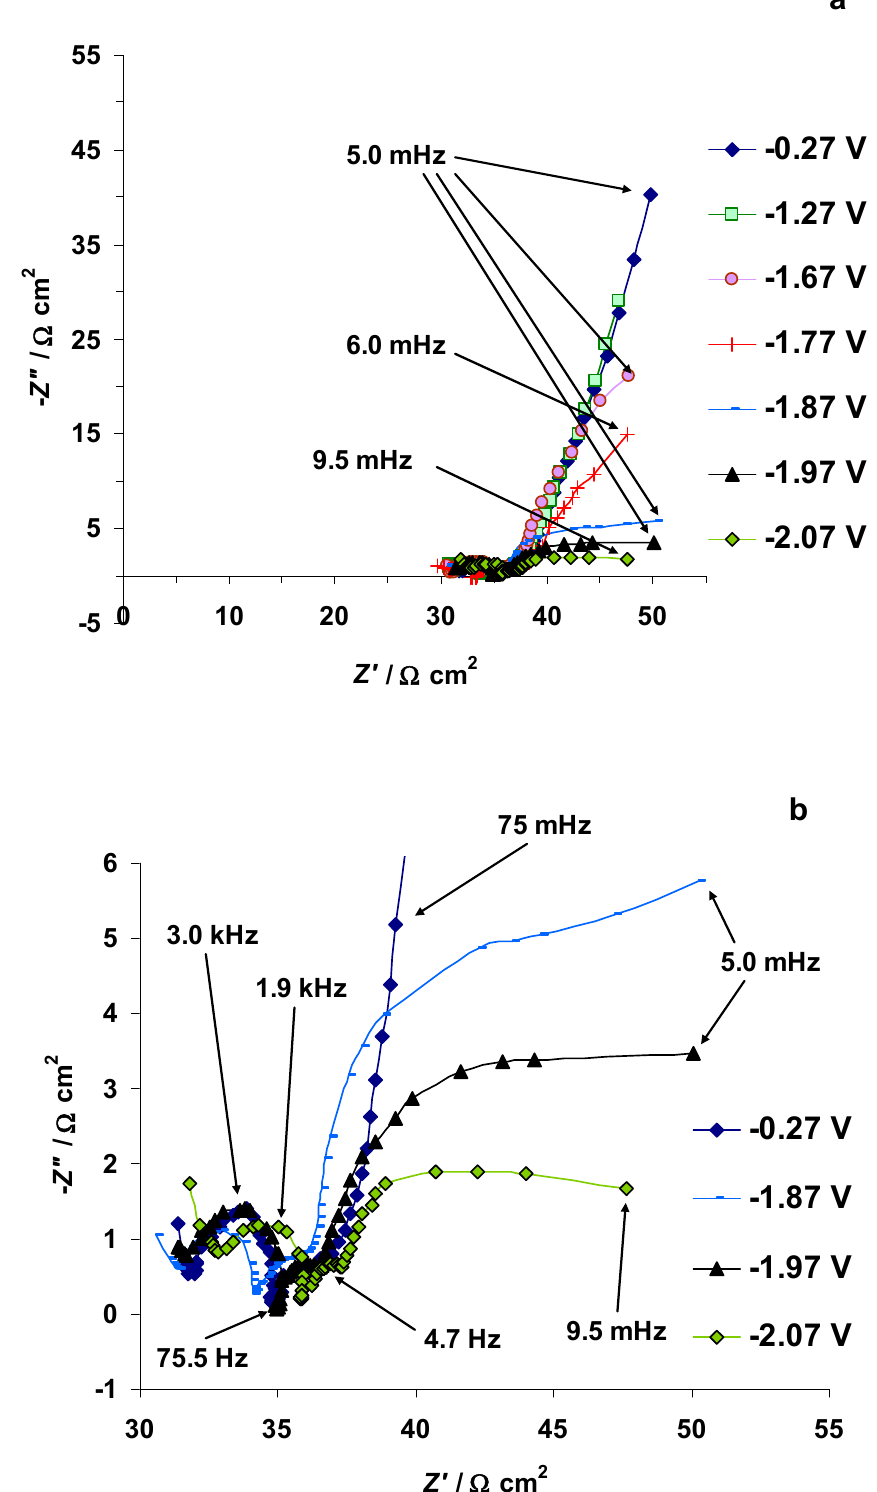
Figure 8. Electrochemical impedance spectroscopy Nyquist plots measured for the 5 wt % EMImBr solution in the EMImBF 4 –C(Mo 2 C) system ( a ) at variable C(Mo 2 C) electrode negative potentials and ( b ) at selected C(Mo 2 C) electrode negative potentials where intensive EMIm–EMIm dimer formation has started. Z (cid:48) and Z ” mark the real and imaginary parts of the electrochemical impedance,